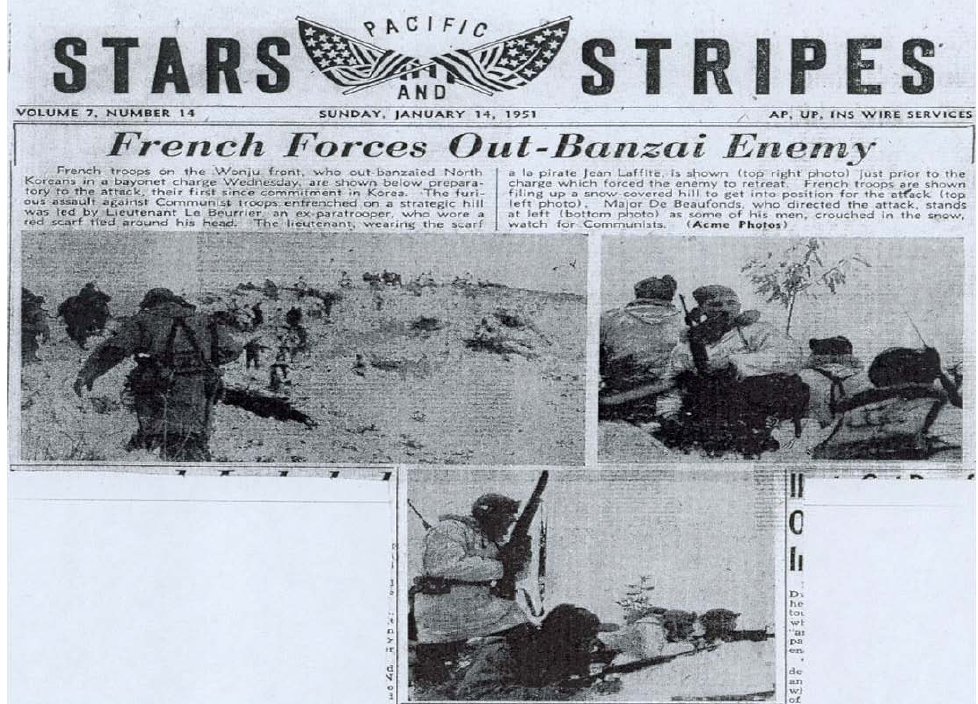
Source : French Diplomatic